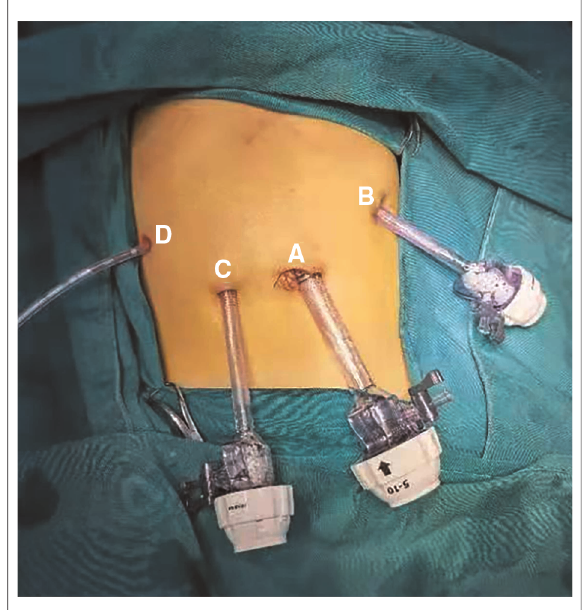
FIGURE 2 Intraoperative trocar and postoperative drainage tube layout. ( A ) Laparoscope hole ( B ) main operation hole ( C ) backup operation hole ( D ) auxiliary operation hole and postoperative drainage tube